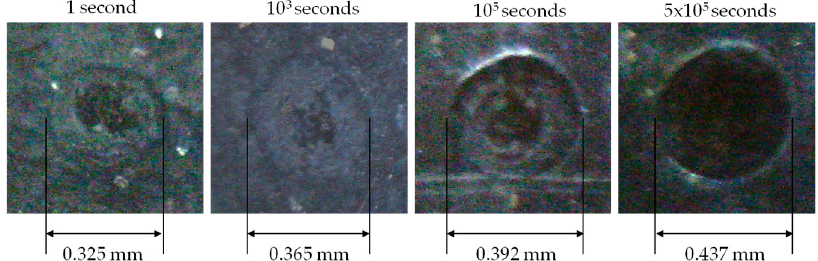
Figure 3. Image of a plastically deformed region on an electro-deposited coating after different durations of static contact at a normal force of 49 N.